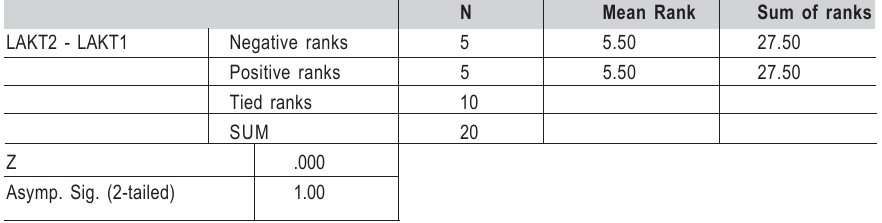
.002 Table 2.Table 2.Table 2.Table 2.Table 2. Statistical analysis of Lactobacillus spp. levels before and after use of CHX mouthwash.